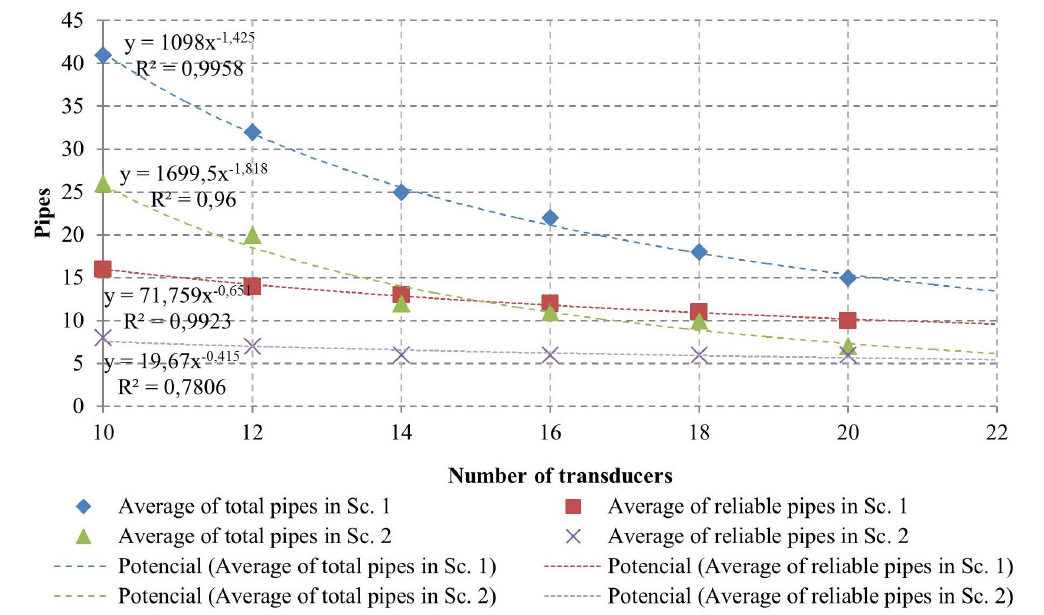
Figure 10. Relationship between the number of pressure transducers and the number of total and reliable